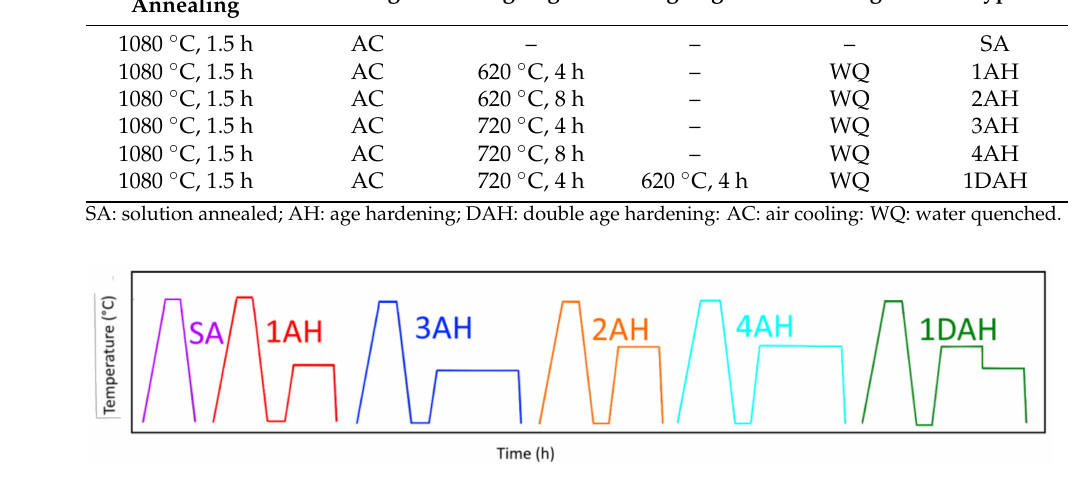
Figure 3. Schematic representation of 6 heat treatment cycles performed in this